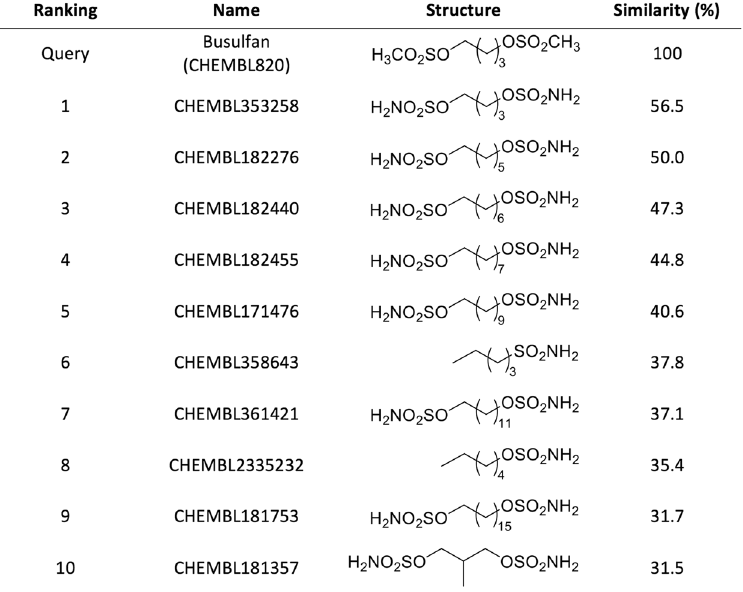
Figure 3. The top 10 hits for the Busulfan query are shown ranked by similarity. The approved drug Busulfan (ChEMBL820) is an alkylating agent. All these hits bind to the predicted target, Carbonic anhydrase 2 (target CHEMBL205), and hence this is a L = 1 target prediction. Since Carbonic anhydrase 2 is not a known target of Busulfan, this is one of the seven L = 1 false positives. This seems to be a genuine false positive due to the relatively low similarity of the hits to the query molecule